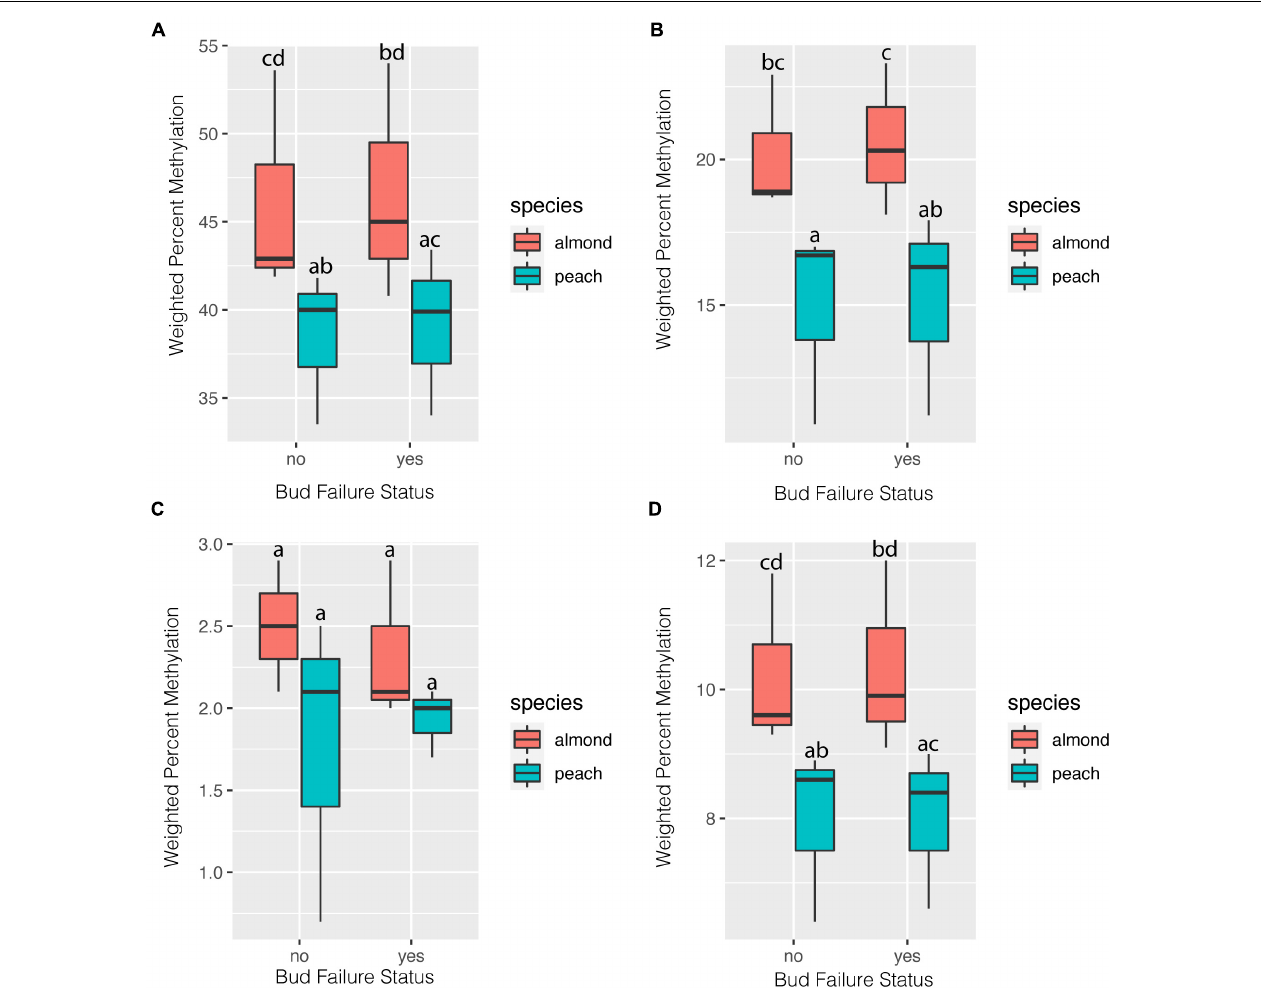
FIGURE 1 | Weighted genome-wide percent methylation in NBF ( n = 3) and no-NBF hybrids ( n = 3) based on alignment to both the almond and peach reference genomes. Weight percent methylation is reported for each methylation context [CG (A) , CHG (B) , and CHH (C) ] as well as total percent methylation (D) . Error bars represent 95% confidence intervals. Letters represent significance groupings for each methylation context and context determined by beta regression and least squares means with Sidak correction (alpha =